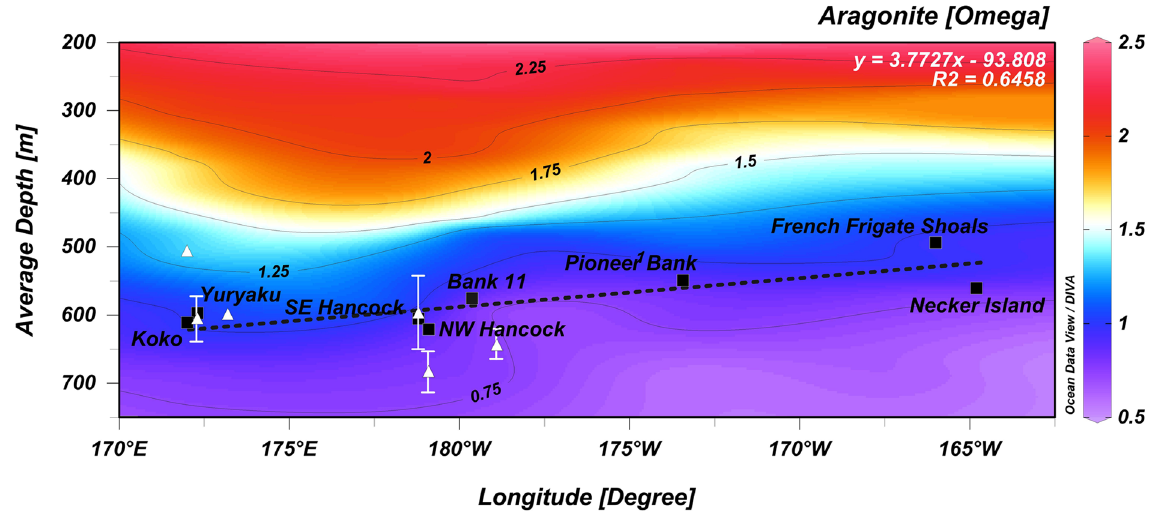
Figure 4. Depth of the aragonite saturation horizon (ASH) at each site with the mean depth of occurrence of scleractinian reef for each site. Black squares are mean ASH depth for each site. White triangles are mean + 1 SD for reef occurrence depth. Note that the mean depth of reefs falls below the ASH for most sites.